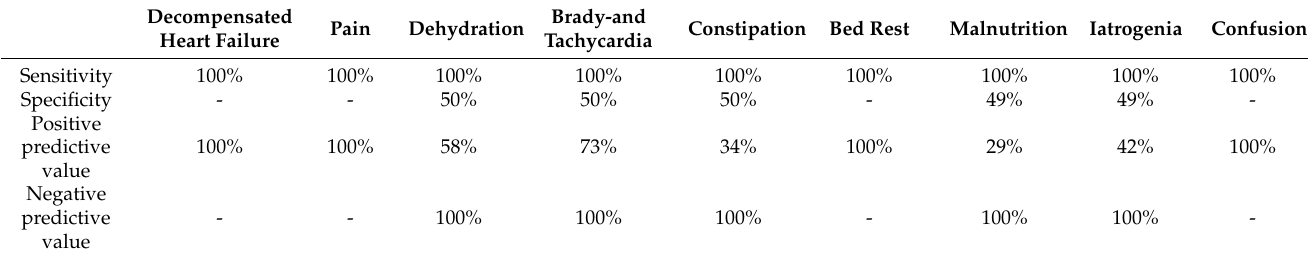
Table 6. Sensitivity, specificity, and positive and negative predictive values for alerts from the MyPredi™ remote monitoring